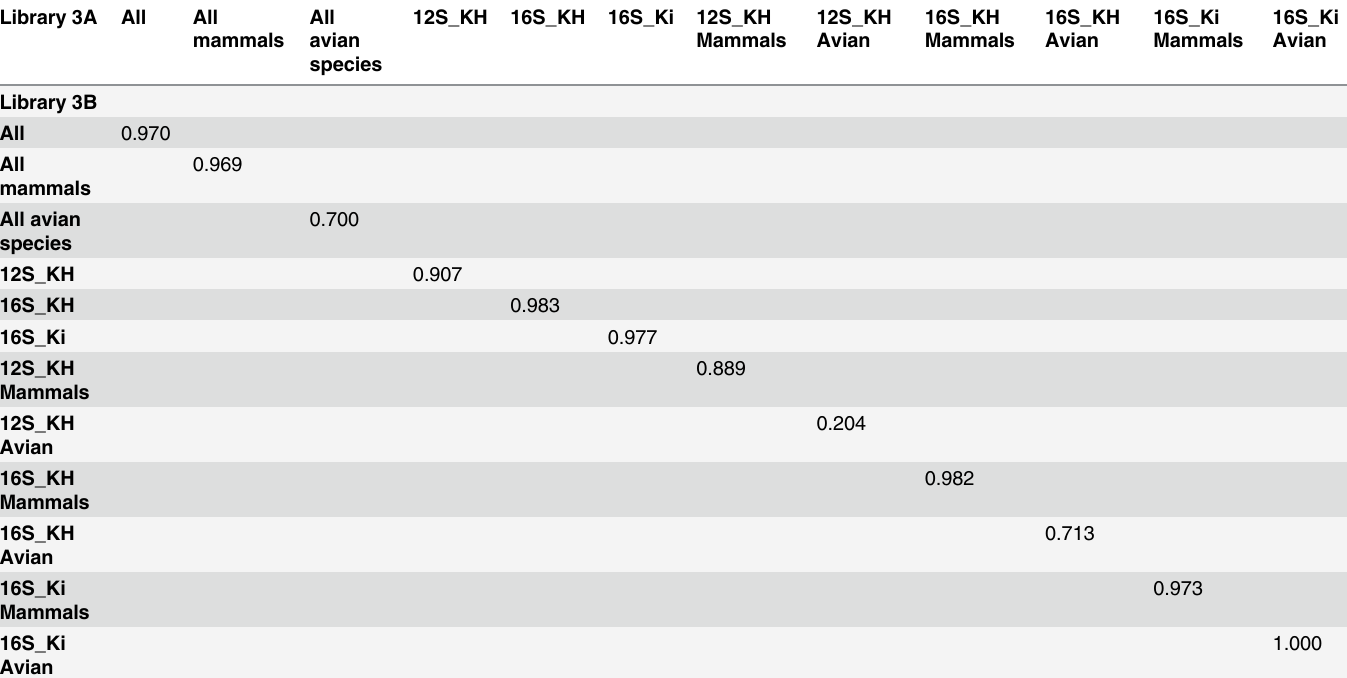
Fig 3. Percentage of reads obtained from libraries 3A and 3B for the different species and primer pairs combinations. doi:10.1371/journal.pone.0121701.g003 Table 4. Pearson ’ s correlation between the number of mapped reads obtained from libraries 3A and 3B using different primer